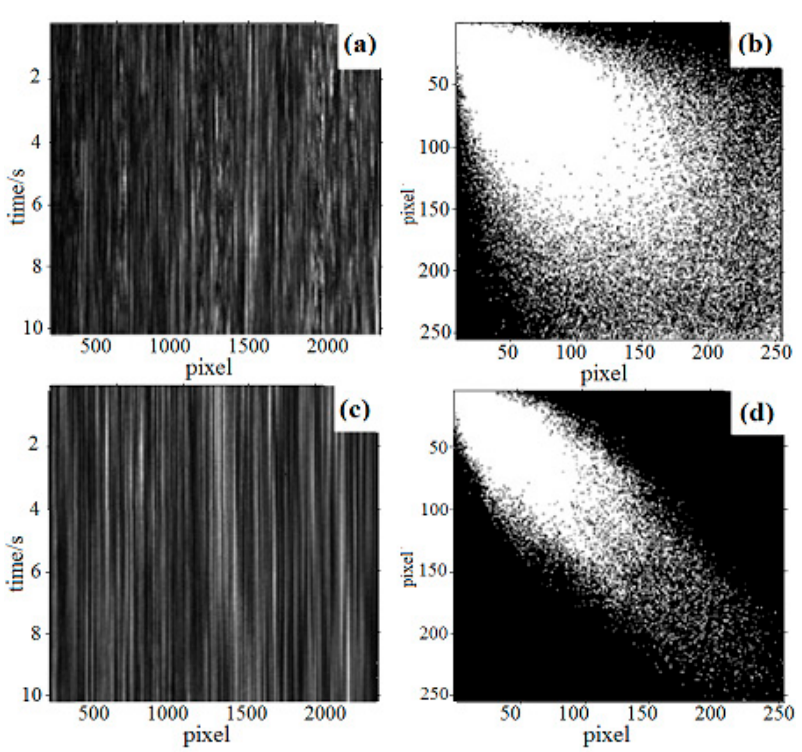
Figure 1. The comparison of time history of the speckle pattern (THSP) and Co-occurrence Matrix (COM). ( a ) THSP in air; ( b ) COM in air; ( c ) THSP in PBS solution; ( d ) COM in PBS solution.